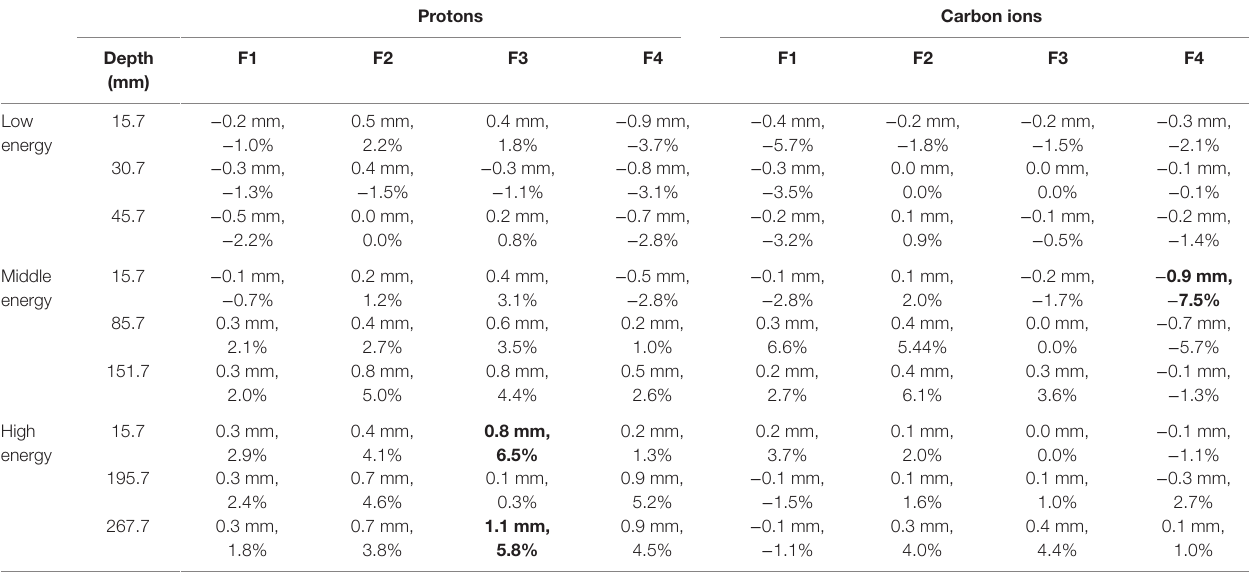
Measurements are the reference FWHM. “Low energy” corresponds, respectively, for protons and carbon ions, to 80.90 and 150.42MeV/u, “middle energy” to 157.43 and 299.94 MeV/u, and “high energy” to 221.06 and 430.10 MeV/u. The numbers in bold correspond to the most extreme variation observed for protons and carbon ions.